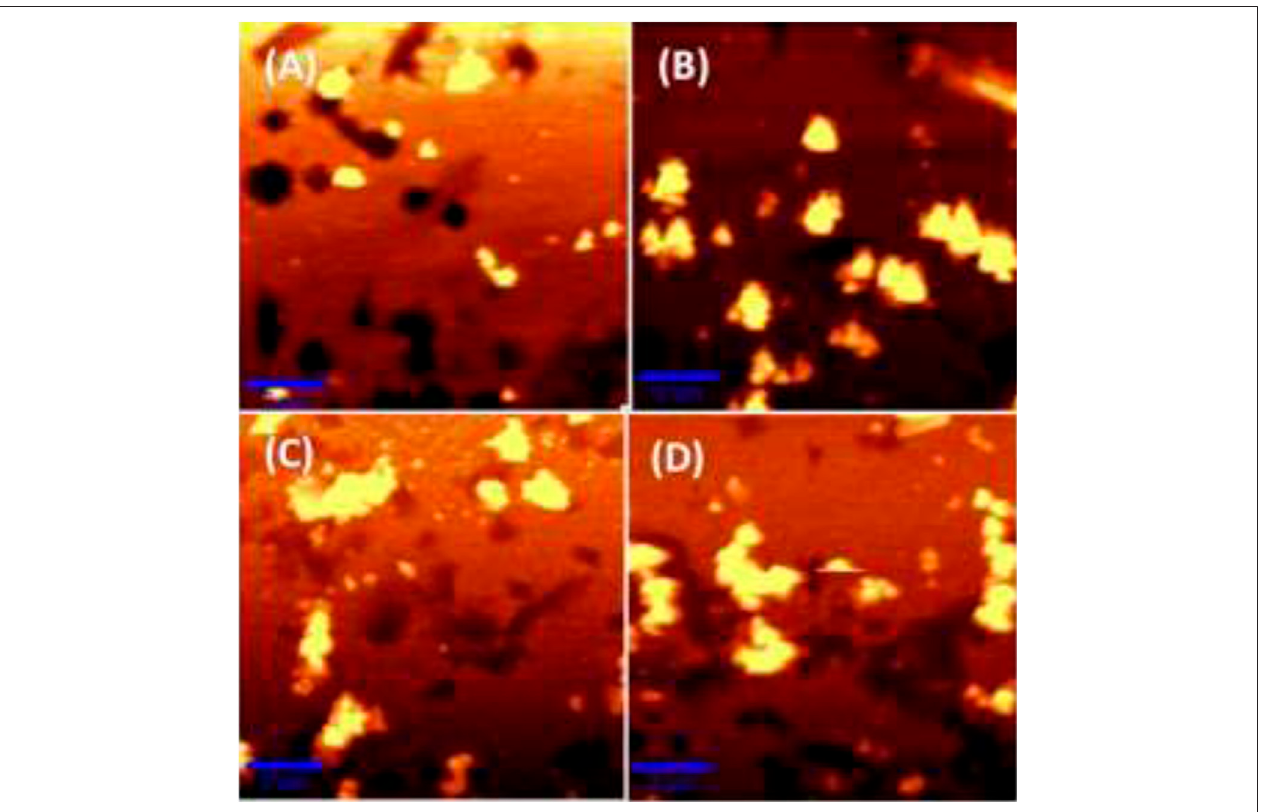
FIGURE4| AFMimagesof (A) barenanostructuredSCF, (B) MC-SCFs(MCconcentration,10 nM), (C) MC-SCFs(MCconcentration,100 nM),and (D) MC-SCFs (MC concentration, 1000 nM).